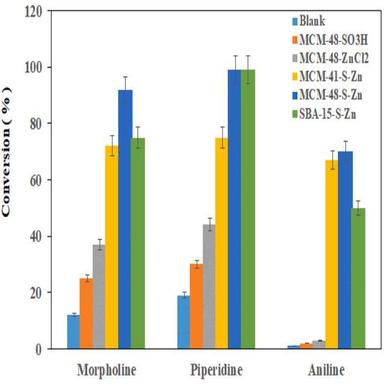
Conversion of Morpholine; Piperidine and Aniline. Reaction condition: Catalyst amount, 20 mg; Temperature, 80 ◦C; Reaction time, 6 h; Morpholine, 10 mmol; Piperidine, 10 mmol; Aniline, 10 mmol; Propylene oxide, 10 mmol.